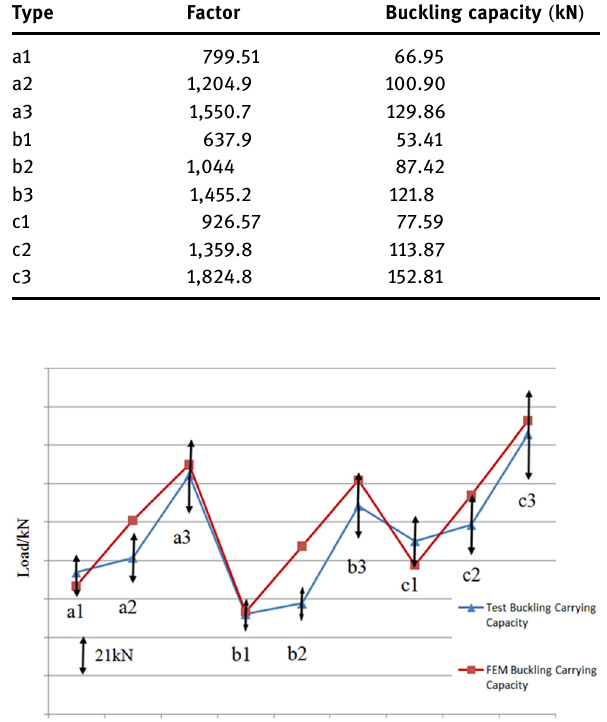
Table 7: FEA bending results Type